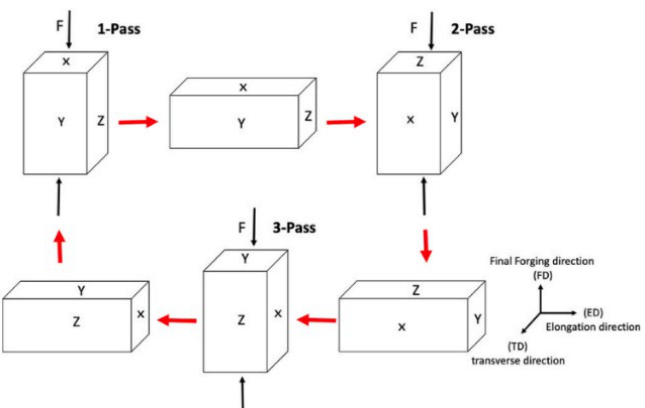
Figure 17. The main structure of MDF reprinted with permission from Ref. [58]. Copyright 2022, ELSEVIER.